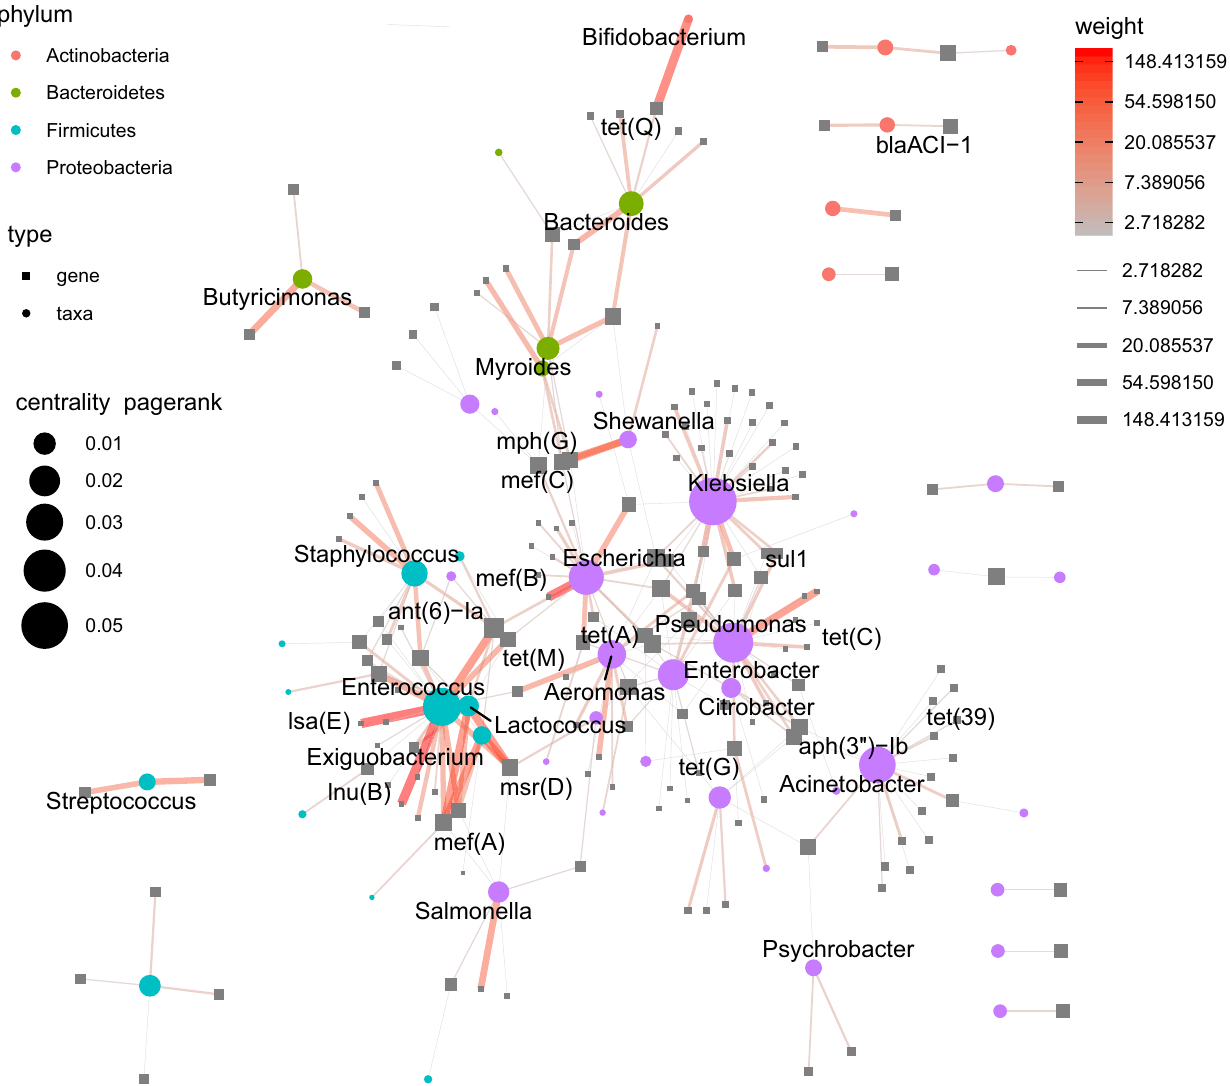
Fig. 4 | Gene-sharing network between bacterial genera. Edges link ARGs to the genera which their contigs were taxonomically assigned to. Only fl anked, non- plasmidic contigs were used. The backbone algorithm was used to compute the graph layout. Color and thickness of edges denote the number of observed taxa-